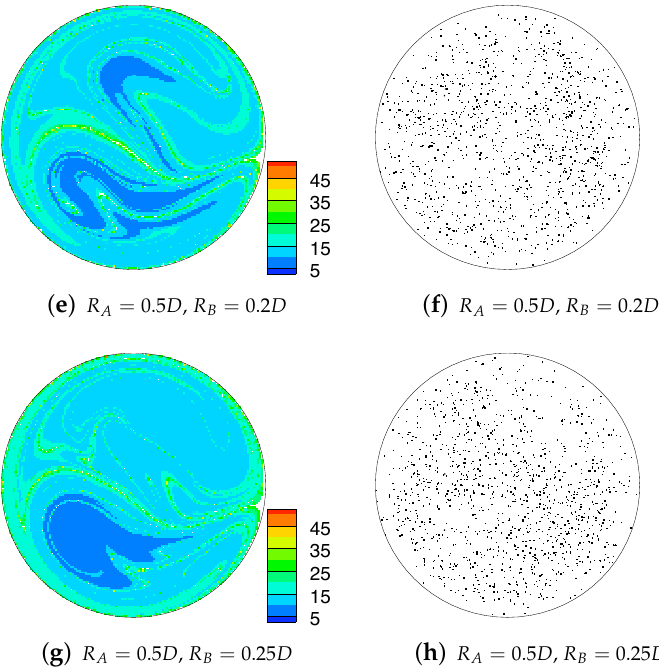
Figure 9. Initial particle distribution, coloured by total residence time of the particle over six pitch lengths ( left ) and Poincaré sections generated by 50 iterations of the combined mapping ( right ). Islands of ’no mixing’ can be seen to correspond in both Poincaré sections and residence